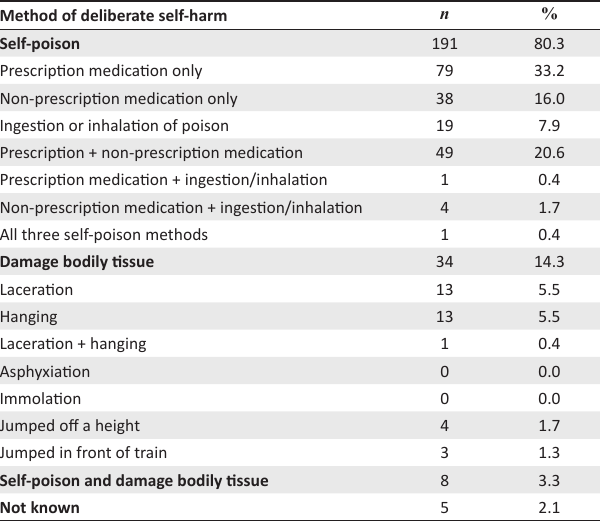
TABLE 2: Method of deliberate